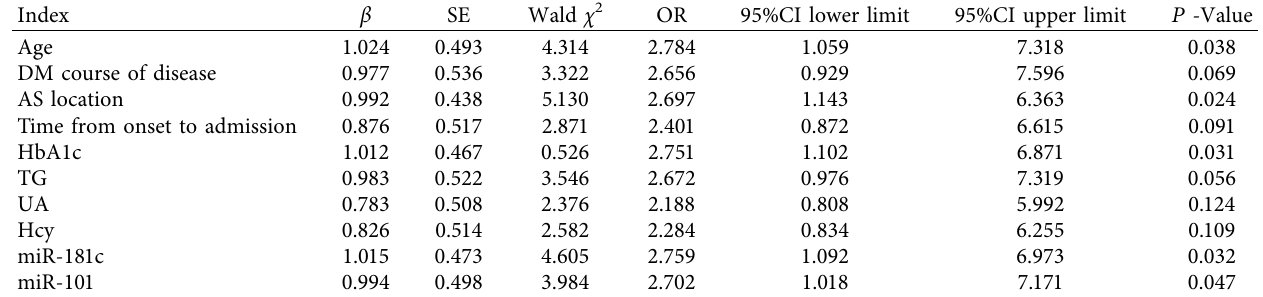
Table 3: Logistic regression analysis on the influencing factors of CI in patients with DM complicated with AS.